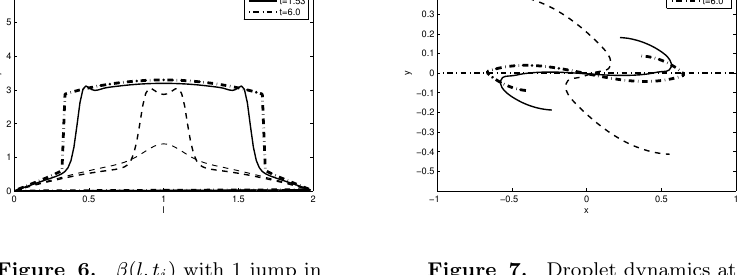
Figure 6. β ( l,t i ) with 1 jump in dependence on l for ωτ = 0 ⇒ 5, t f = 6.